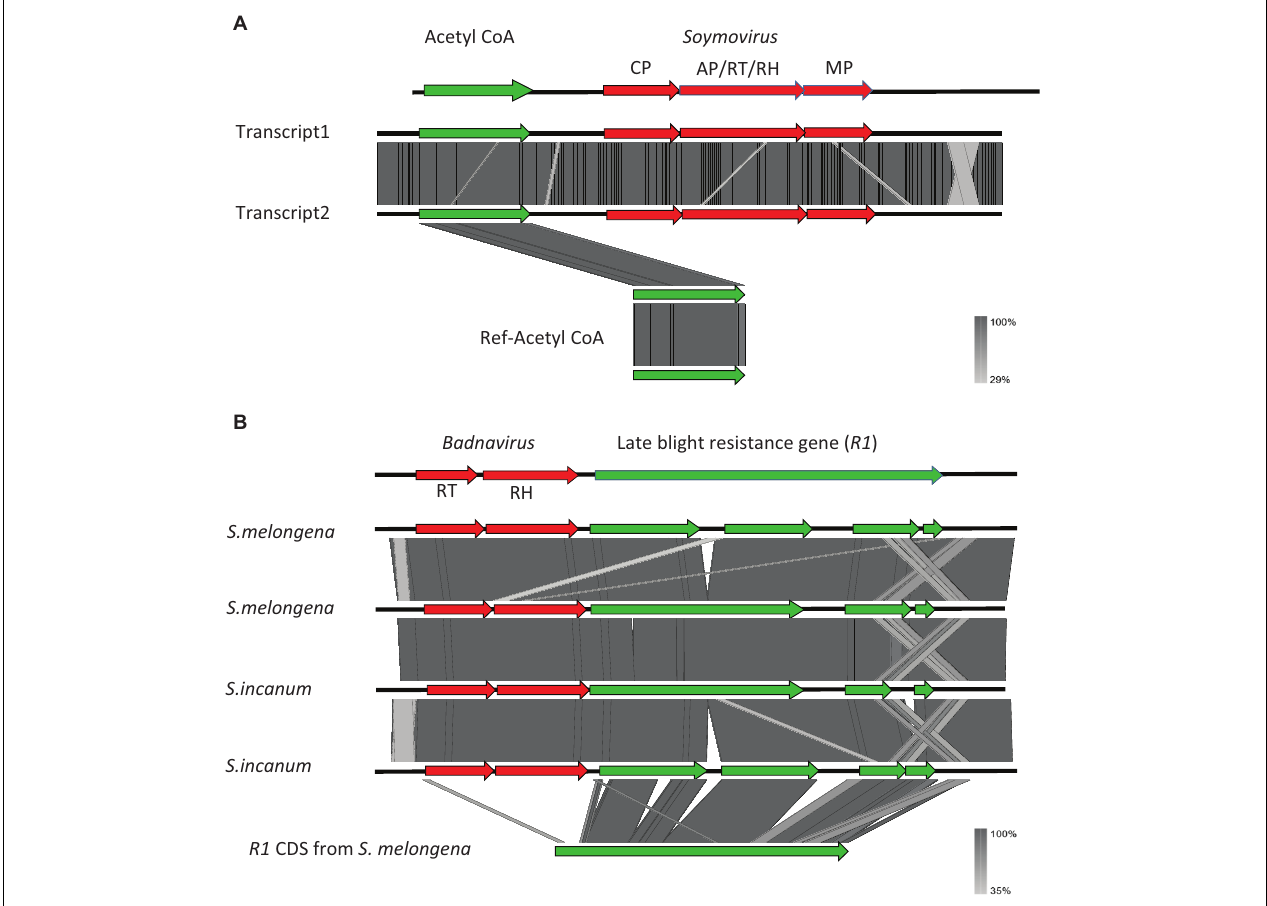
FIGURE 1 | Structure of the co-transcripts identified in alfalfa ( Medicago sativa ) (A) and eggplant ( Solanum melongena ) and Solanum incanum (B) . Viral sequences are shown in red and host sequences are shown in